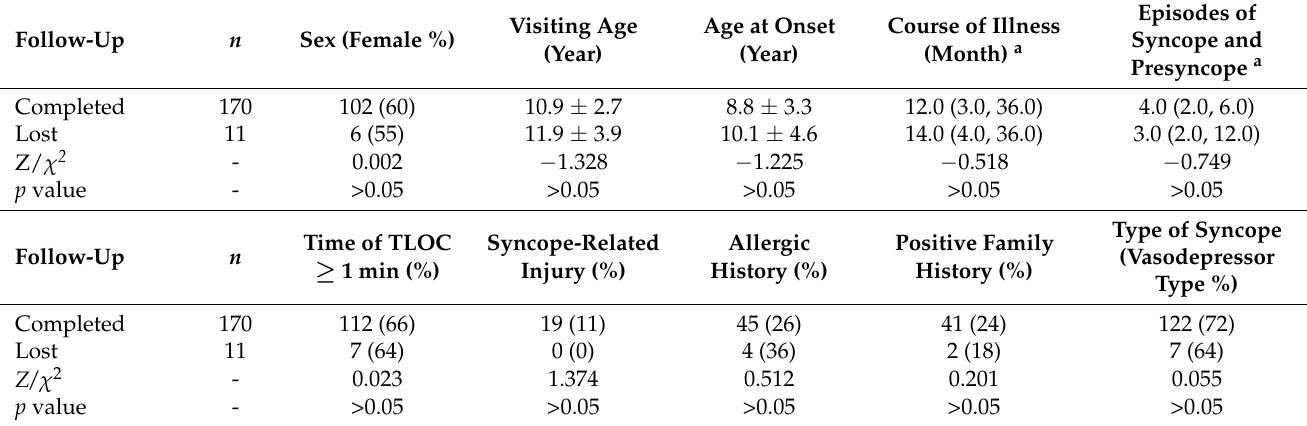
Table 1. Clinical characteristics of study participants who completed and lost to follow-up.